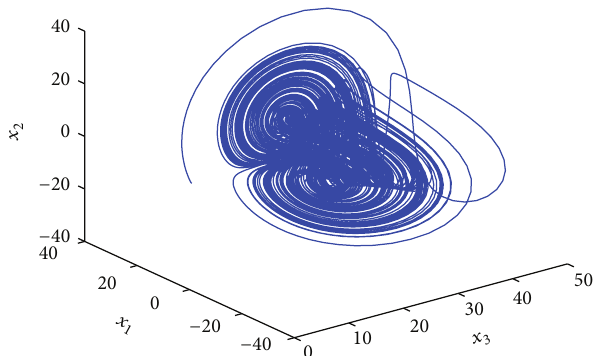
Figure 1: The chaotic attractor of fractional order Chen system with 𝑞 = 0.96 .